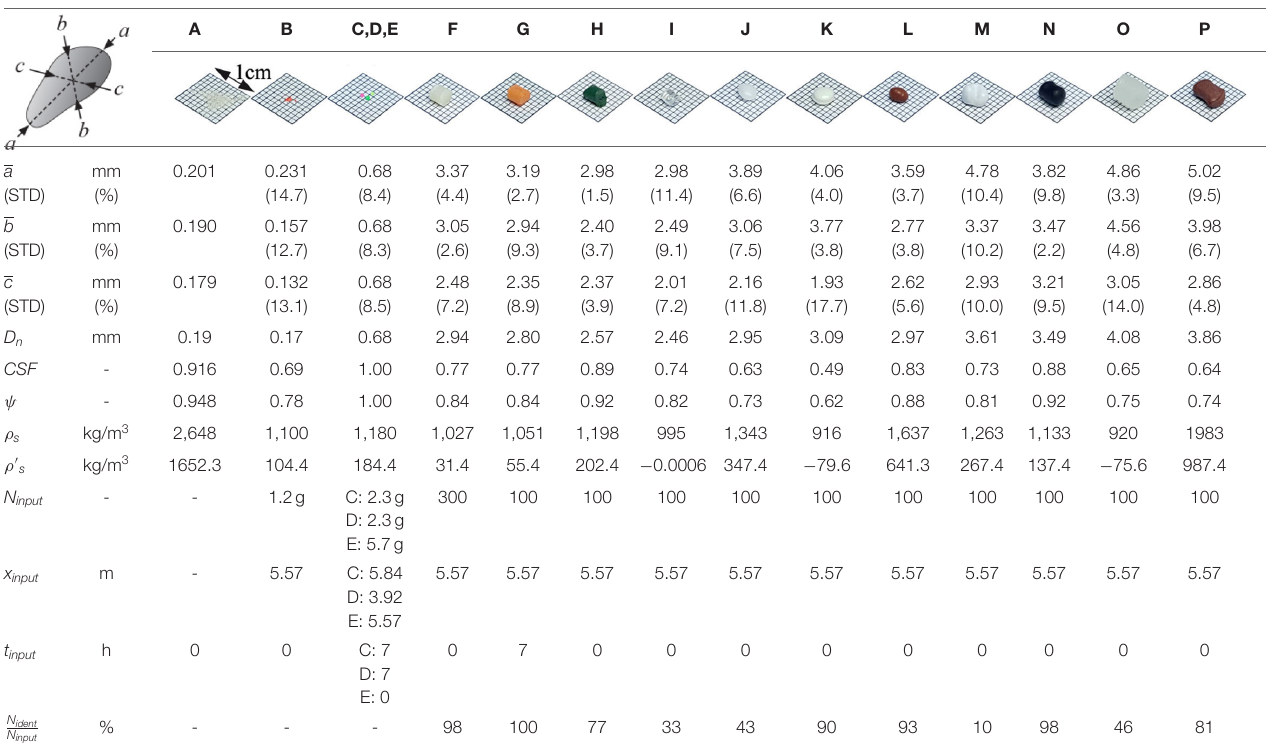
TABLE 2 | Sediment and tracer